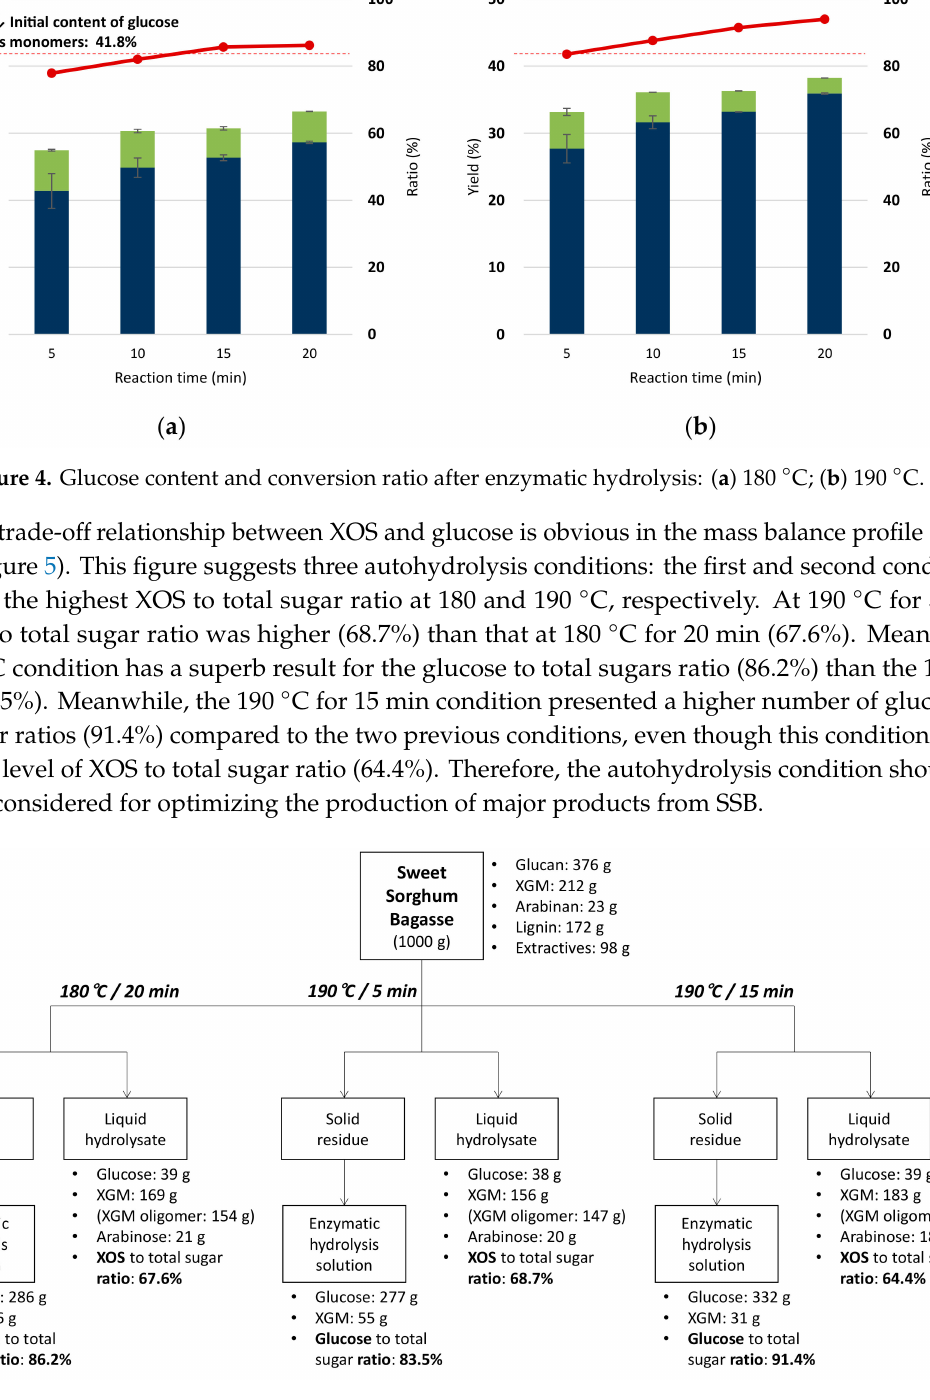
Figure 5. Mass balance of the XOS and glucose production from sweet sorghum